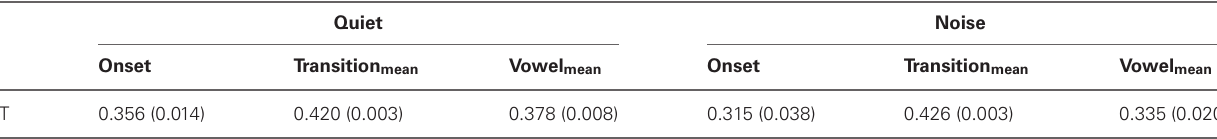
Table 6 | Correlations (with significance levels) between peak latency for the onset, transition, and vowel peaks for the two conditions (i.e., Quiet and Noise) and HINT.